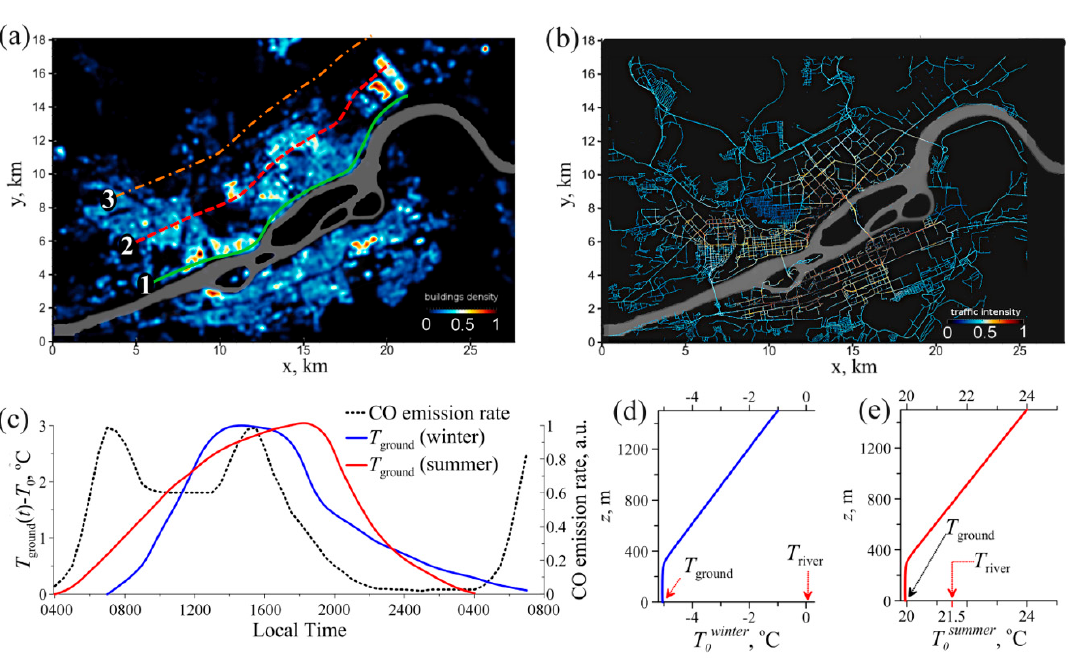
Figure 2. Krasnoyarsk urban canopy with the river Yenisei and traffic arteries. ( a ) Relative buildings density map (coloured lines show the averaging path for the statistics, see Section 3.3); ( b ) Traffic activity in different parts of the city; ( c ) Diurnal variation of temperature and concentration emission used in the simulation; ( d , e ) Initial temperature profiles for summer and winter cases. T 0 denotes the initial ground temperature (20 °C in the summer case and − 5 °C in the winter case).